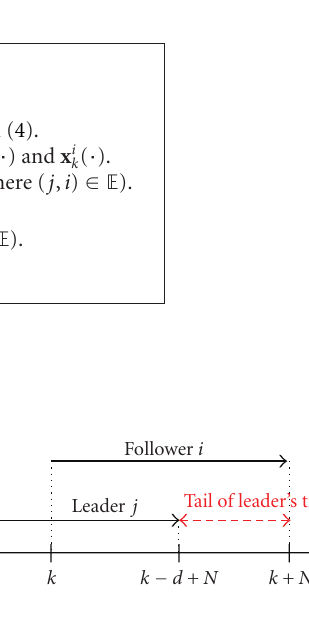
Figure 3: Tail of the leader’s trajectory in the presence of large communication delay d